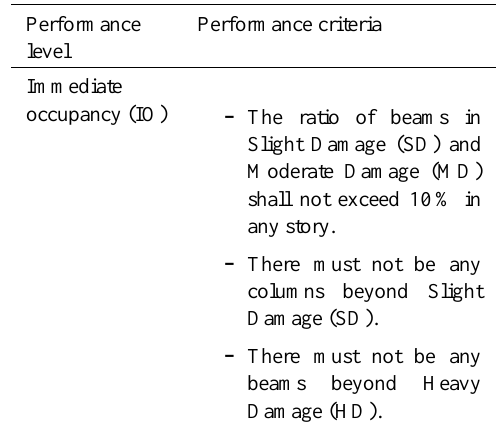
Table 3. Structure performance based on damage in Turkish Earth- quake Code